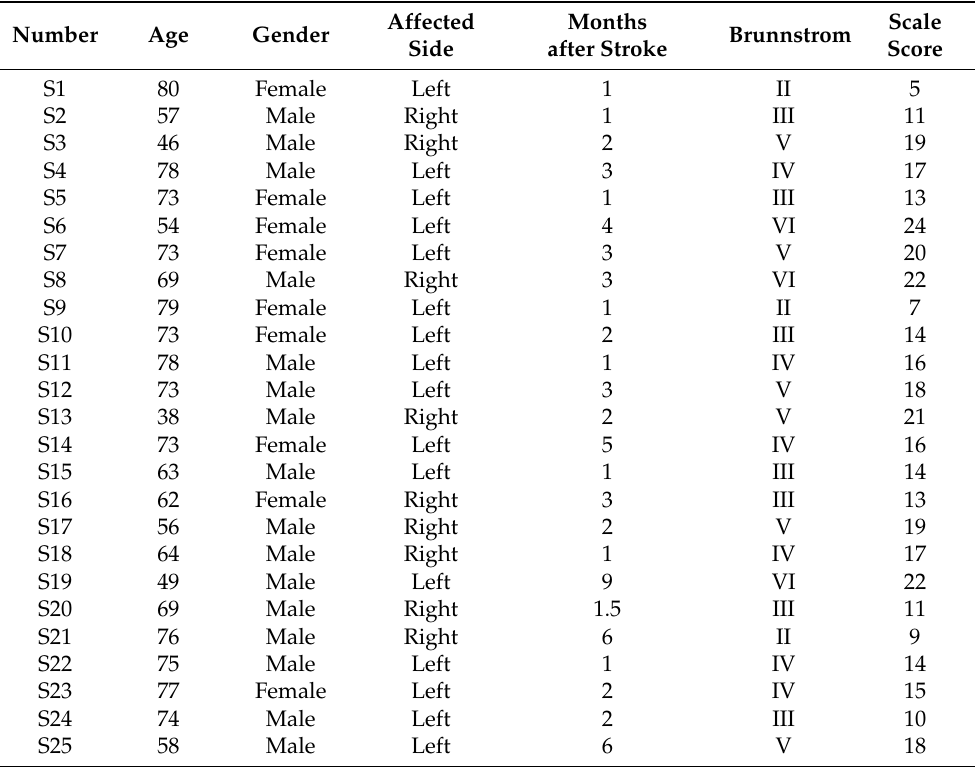
Table 1. Demographic information of patients with wrist motor function